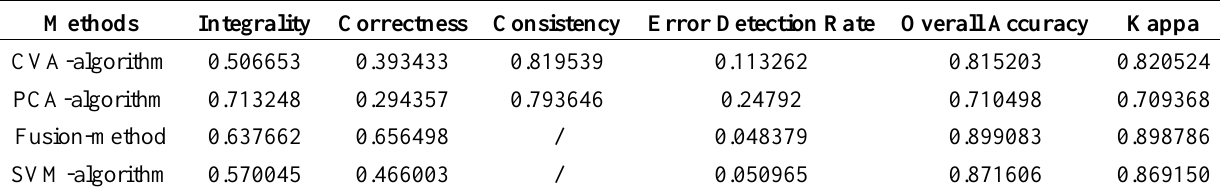
Table 2. Comparison result of data set